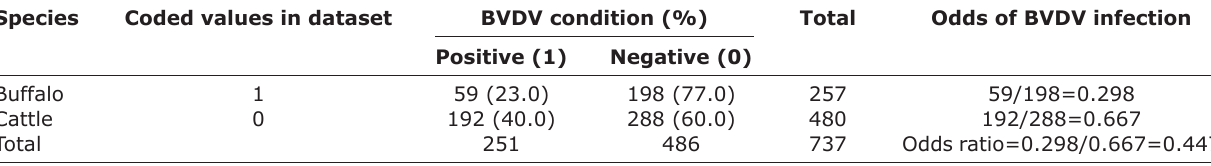
Table-3: Chi-square test for the association between BVD prevalence and species. Species Coded values in dataset